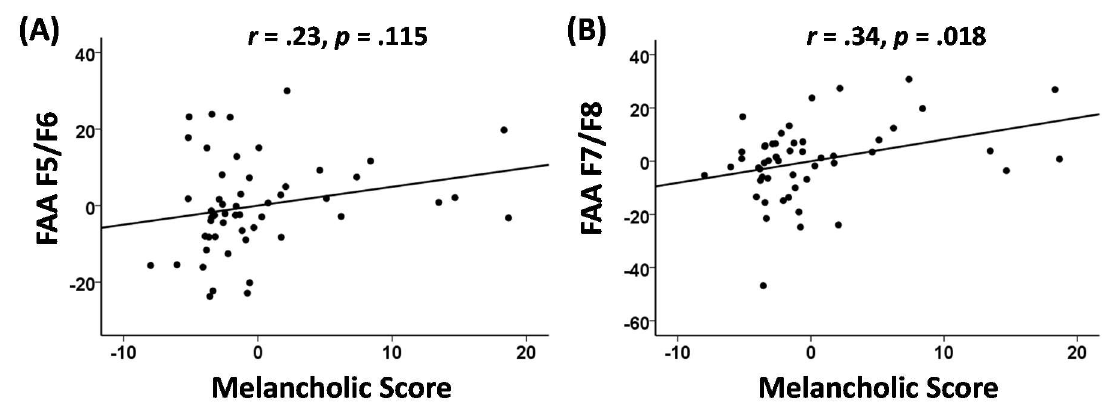
Figure 6. Partial correlation (age, sex, HAM-D at baseline, and medication types as covariates) plots of the positive relation between ( A ) FAA F5 / F6 and melancholia score ( r = 0.23, p = 0.115), and ( B ) FAA F7 / F8 and melancholia score ( r = 0.34, p = 0.018).